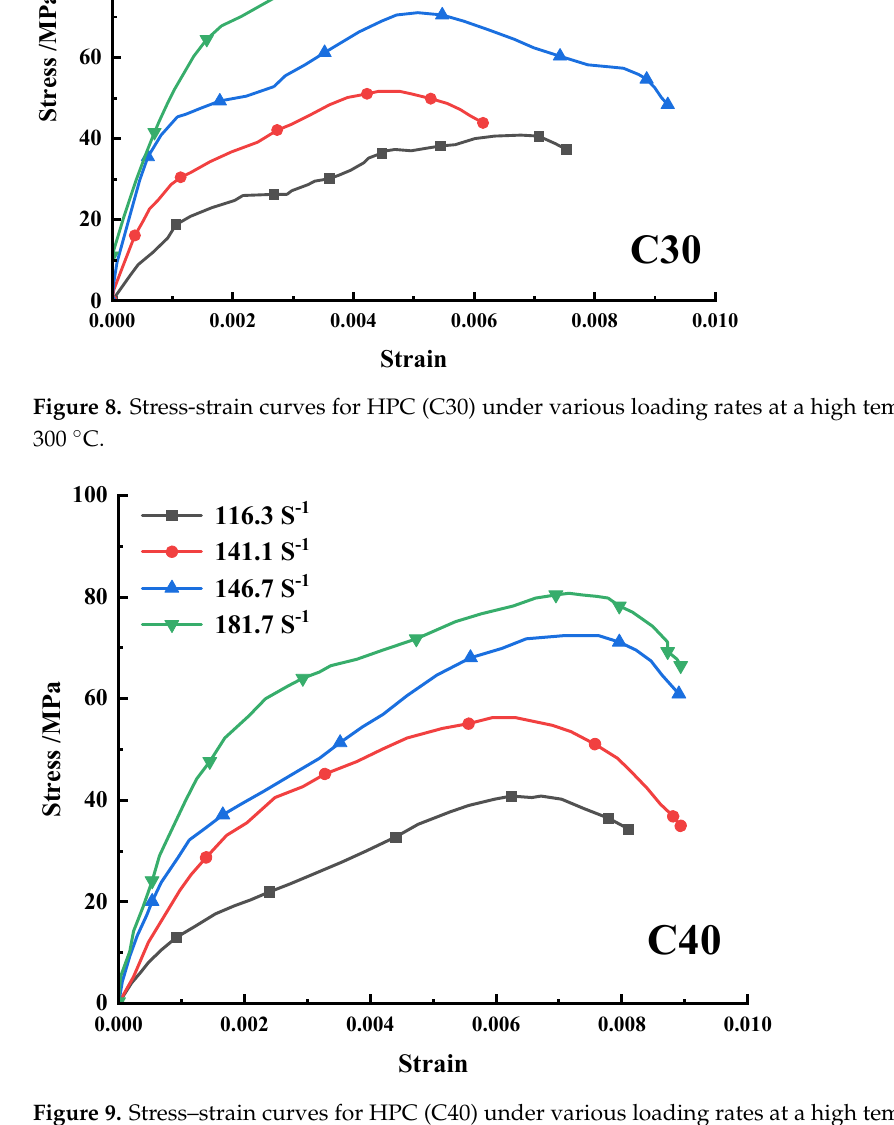
Figure 10. Stress–strain curves for HPC (C50) under various loading rates with a high temperature of 300 °C. For the HPC C30 (Figure 8), at the loading rate of 84.5 𝑆 (cid:2879)(cid:2869) the stress increases with the increase in the strain. At a strain value of approximately 0.0075, the stress reaches its peak, which affects the compressive strength of the specimen, which is approximately 38 Mpa. Thus, at the loading rate of 84.5 𝑆 (cid:2879)(cid:2869) , the loading rate does not significantly influence the compressive strength of the HPC C30. At the loading rate of 92.1 𝑆 (cid:2879)(cid:2869) , the peak stress is about 45 Mpa when the strain is 0.0042. For the loading rate of 139.7 𝑆 (cid:2879)(cid:2869) , the peak stress is about 70 Mpa when the strain is 0.005. This indicates that a higher loading rate can significantly influence the compressive stress of the HPC C30. In addition, the strains are different for the HPC C30 when stress level reach their peak at different loading rates. Figures 9 and 10 indicate the same conclusion: the higher loading rate significantly influences the compressive strength, while the stress levels reach their peaks at different strains for the same kind of HPC.